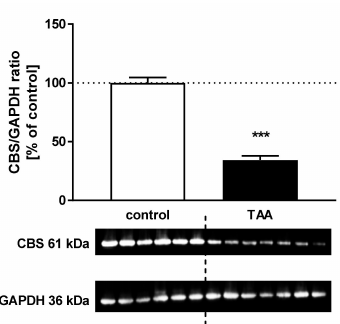
Figure 5. The relative protein level and representative immunoblot of CBS (61 kDa) in the liver of control and TAA rats. The graph represents data normalized to GAPDH (36 kDa) and expressed as a percentage of control. Data are reported as mean ± SEM, n = 6–7. *** p < 0.001 compared with control.